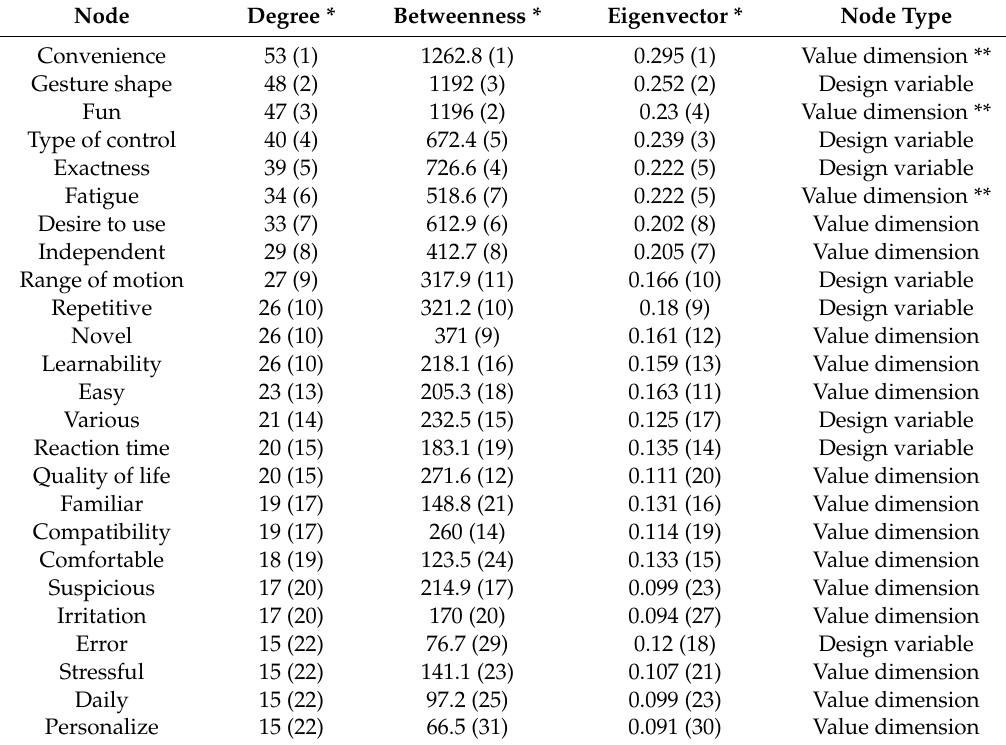
Table 1. Centrality of representative nodes and their